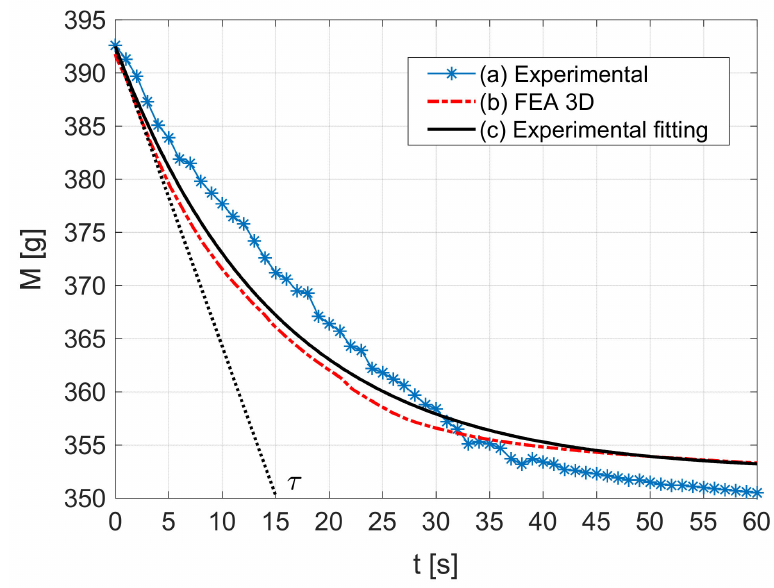
Figure 8. Evolution of the total mass.